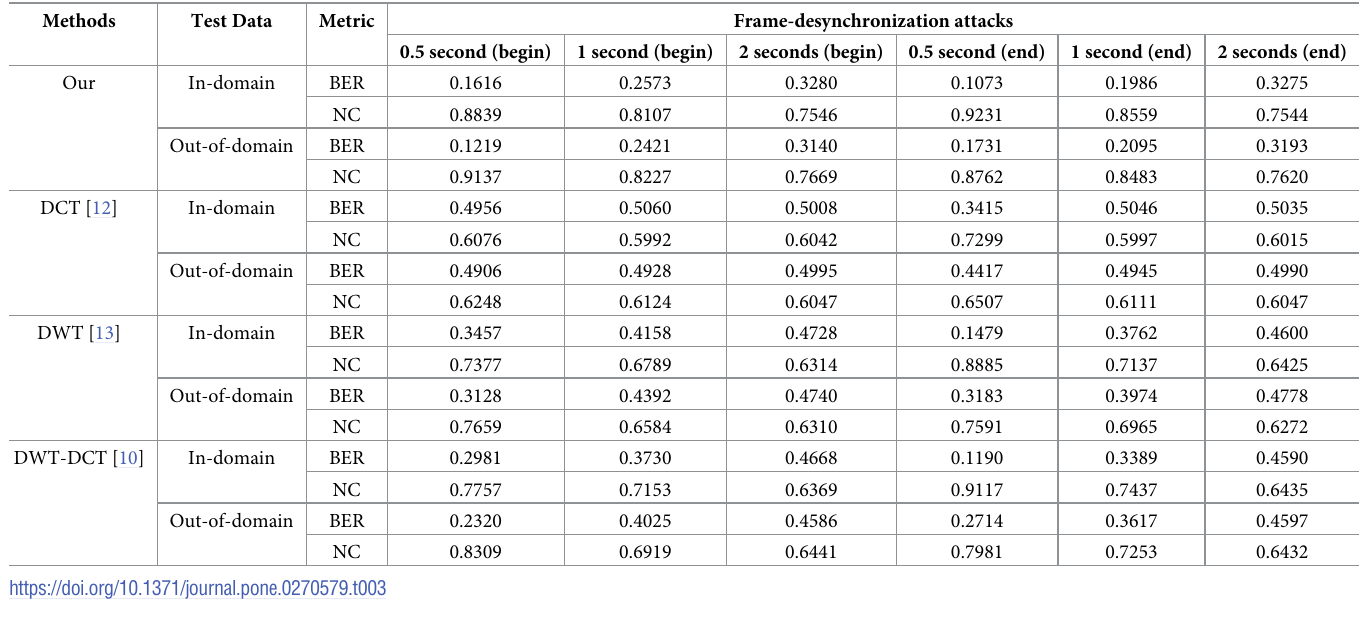
Table 3. Robustness comparison of the proposed scheme and other zero-watermarking schemes under frame-desynchronization attacks. Methods